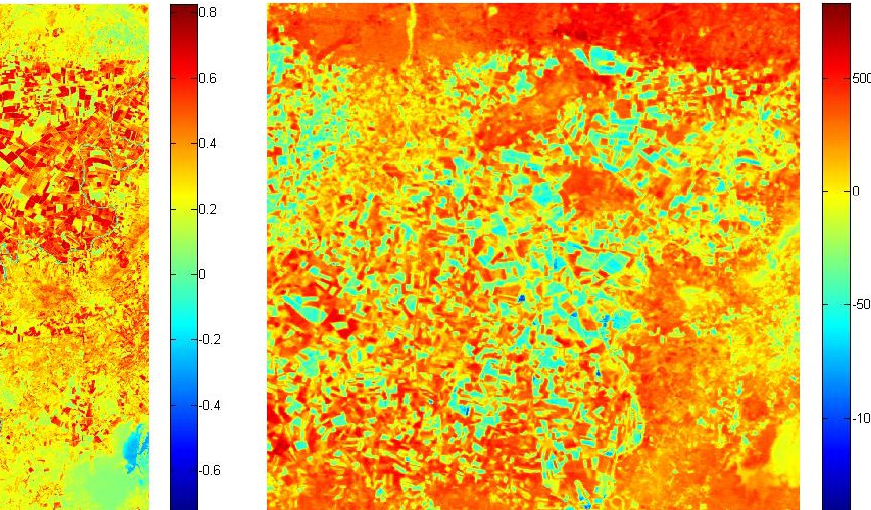
Figure 7. Sensible Heat Flux Map (W/m 2 )